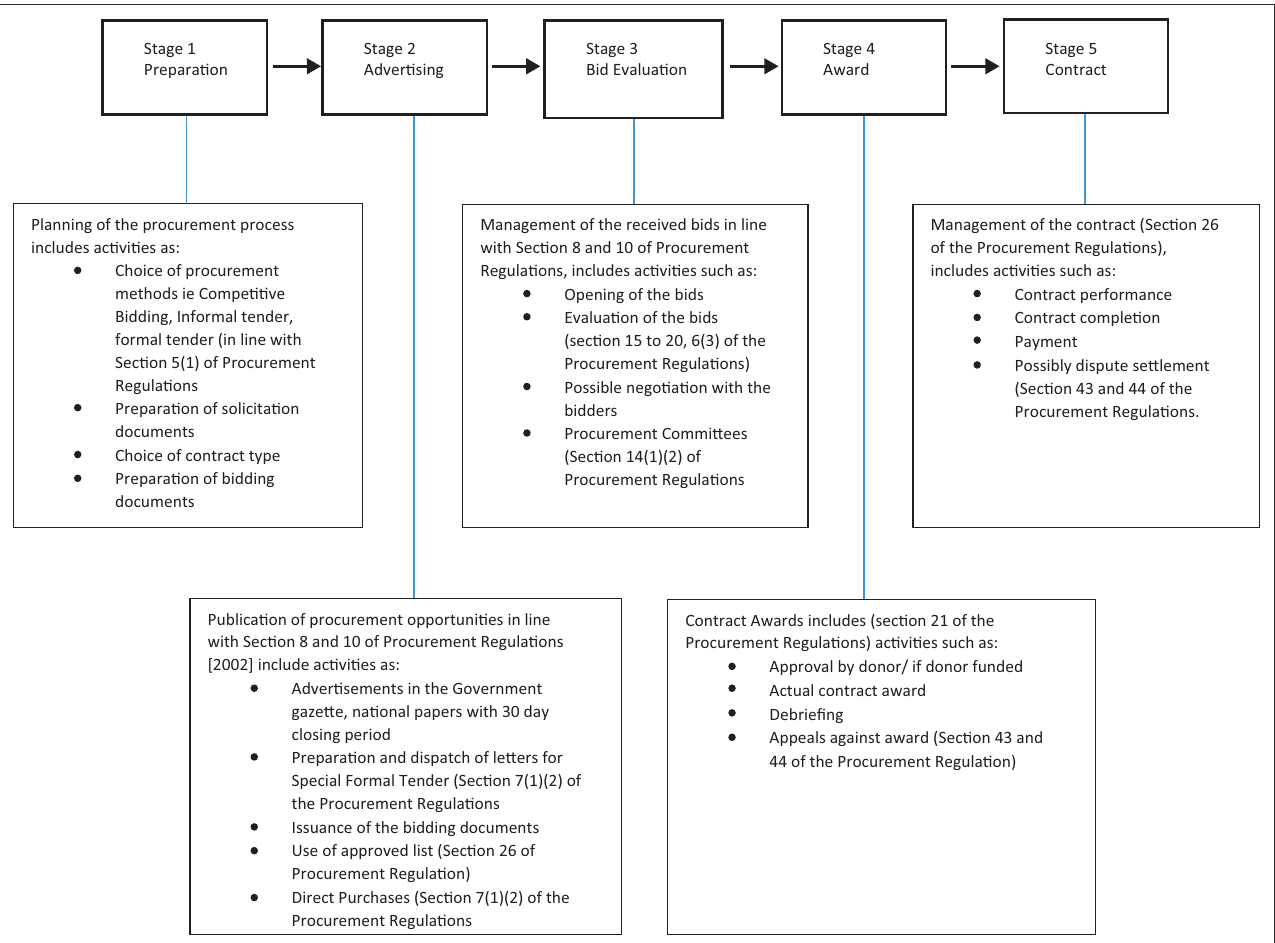
FIGURE 1: Stages in the public procurement process in